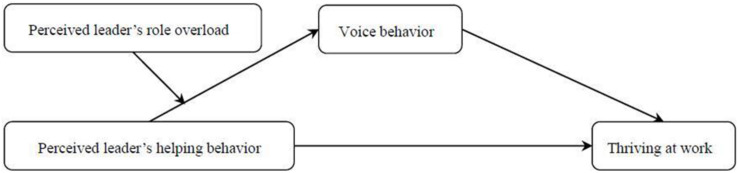
Theoretical model.